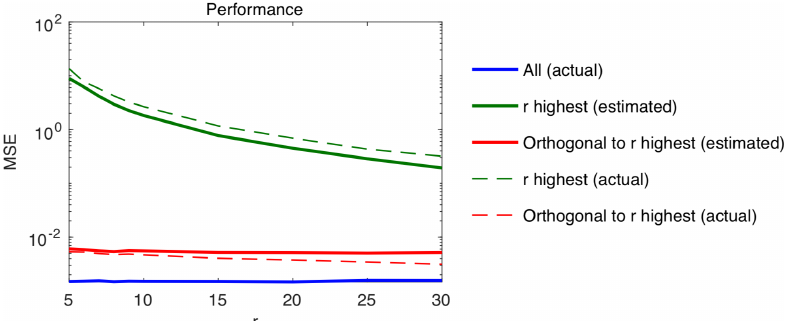
Figure 3. Performance results on simulated data: MSE of several estimators of β (vertical axis) as functions of the number of eigenvectors r (horizontal axis) assumed to be reliably estimable from control runs: conventional estimator b β r computed based on estimated eigenvectors (thick green line) with N = 30, and based on the true eigenvectors (light green line); proposed orthogonal estimator b β ∗ r computed based on estimated eigenvectors (thick red line) with N = 30, and based on the true eigenvectors (light red line); GLS estimator computed based on the true value of the covariance (cid:54) (thick blue